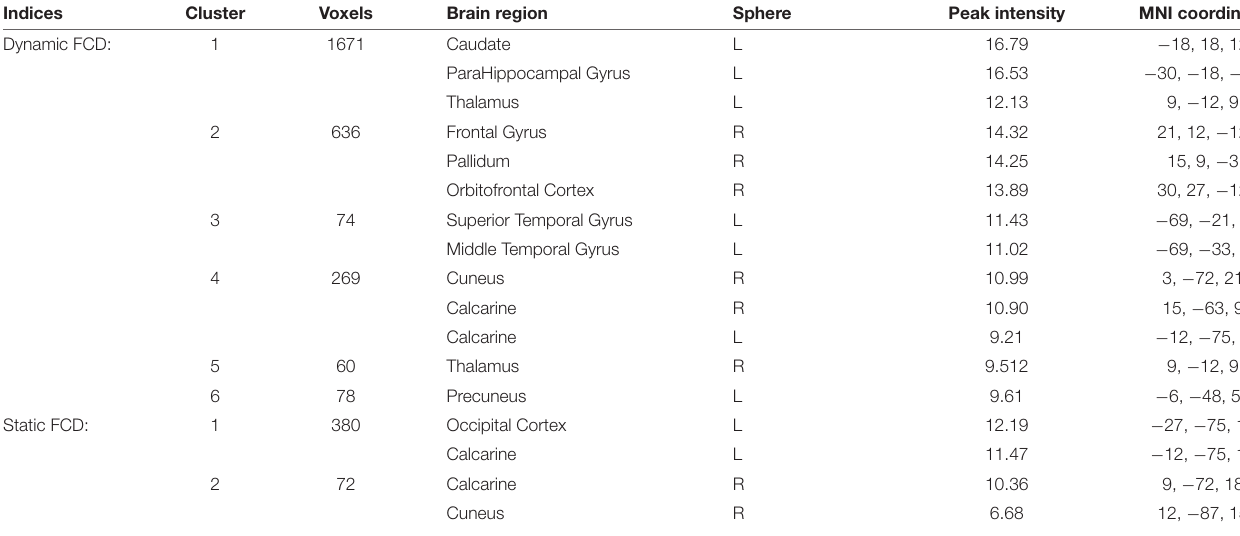
TABLE 2 | Brain regions with changed static and dynamic functional connectivity density (FCD) among the three groups.